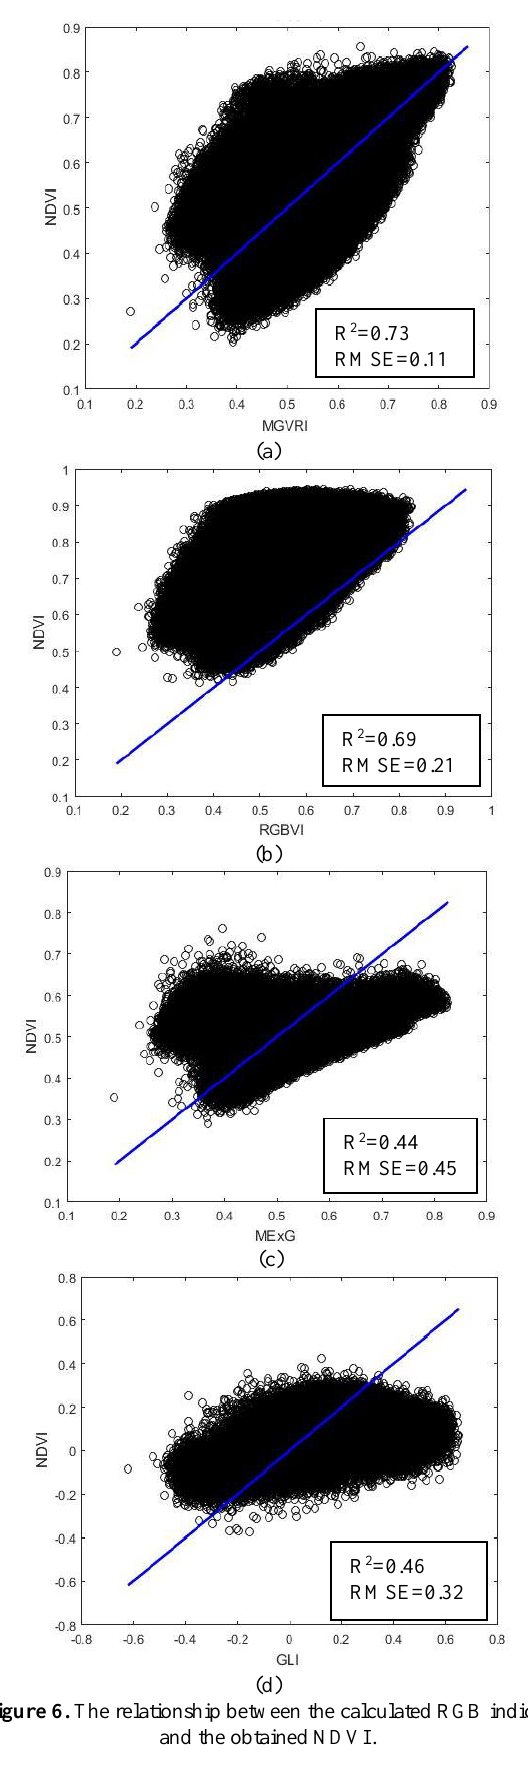
Figure 6. The relationship between the calculated RGB indices and the obtained